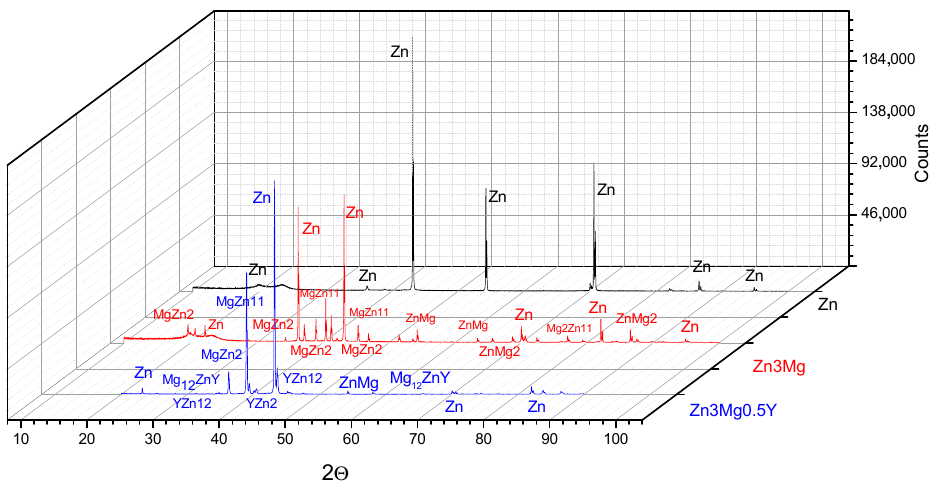
Figure 4. XRD results of Zn, ZnMg, and ZnMgY